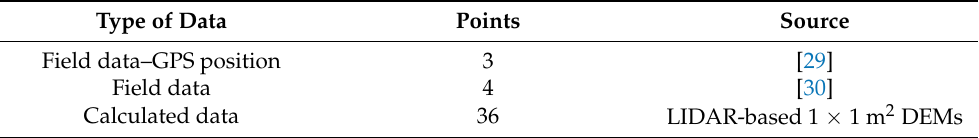
Table 2. Thickness data of the surficial cover available for the study